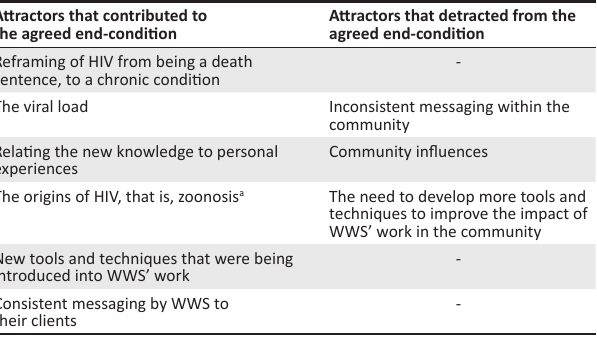
Attractors that detracted from the agreed end-condition